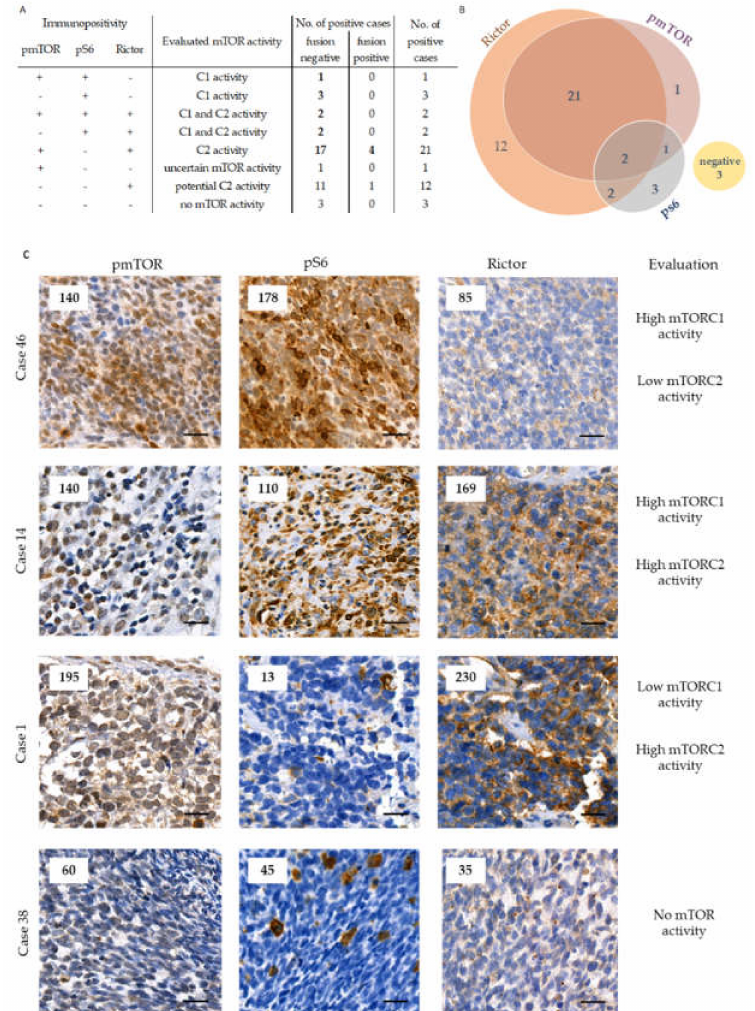
Figure 1. The distribution of the primary cases based on pmTOR, pS6, and Rictor immunostaining results and mTOR activity marker categorization. We present the results of the investigated mTOR markers with the interpretation of mTORC1 and / or C2 activity regarding PAX-FOXO fusion-negative and fusion-positive cases on the left (panel ( A )). The cases with elevated mTOR activity were highlighted with bold numbers. The Venn-diagram (panel ( B )) represents the number of positive cases with each immunohistochemical marker. On panel C representative pmTOR, pS6, and Rictor immunohistochemical stainings are shown for primary RMS cases (panel ( C )). DAB (brown) and hematoxylin were used as chromogen and counterstaining, respectively. The numbers in the left upper corner of the pictures refer to the given H-scores. Pictures were taken with CaseViewer 2.3 software (3DHistech Ltd., Budapest, Hungary). The scale bars show 25 µ